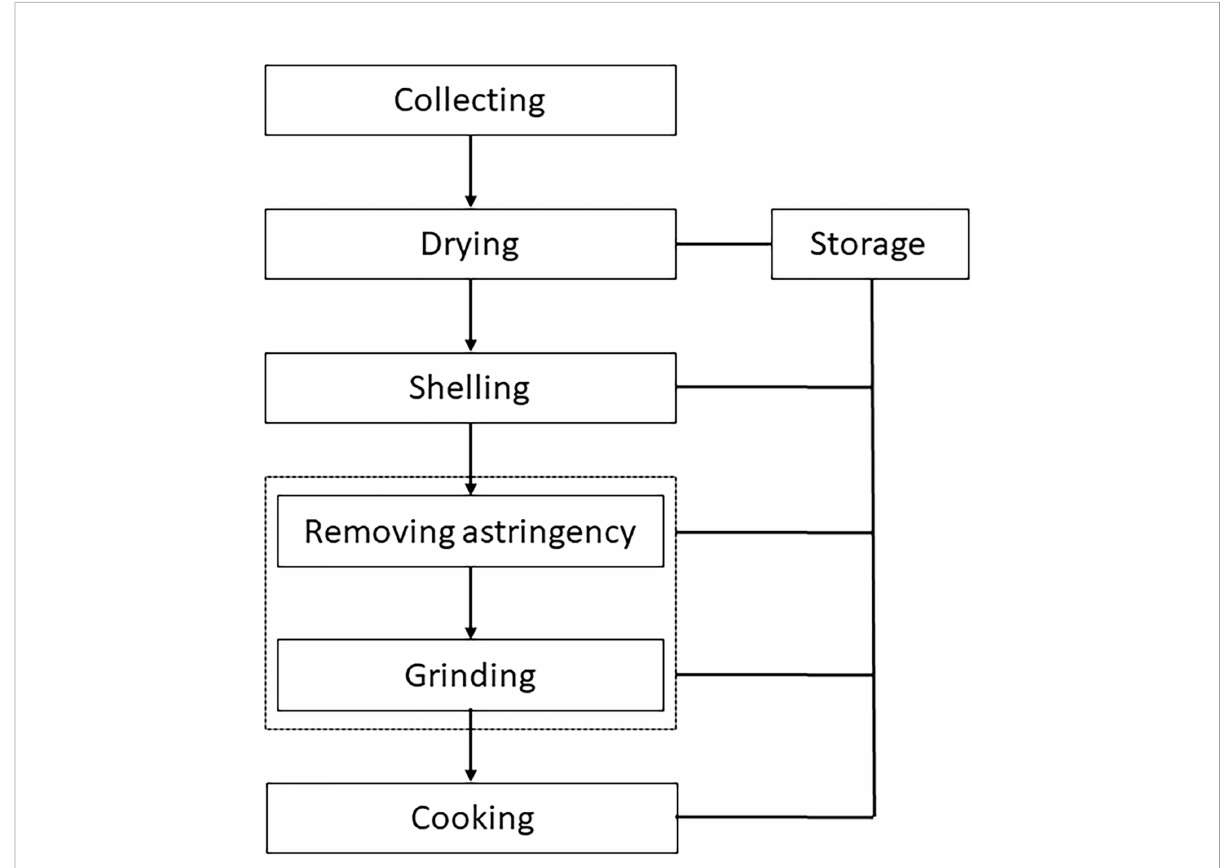
FIGURE 3 Cha ı ̂ ne Ope ́ ratoire of acorn use in current papers. The procedures of removing astringency and grinding can be in